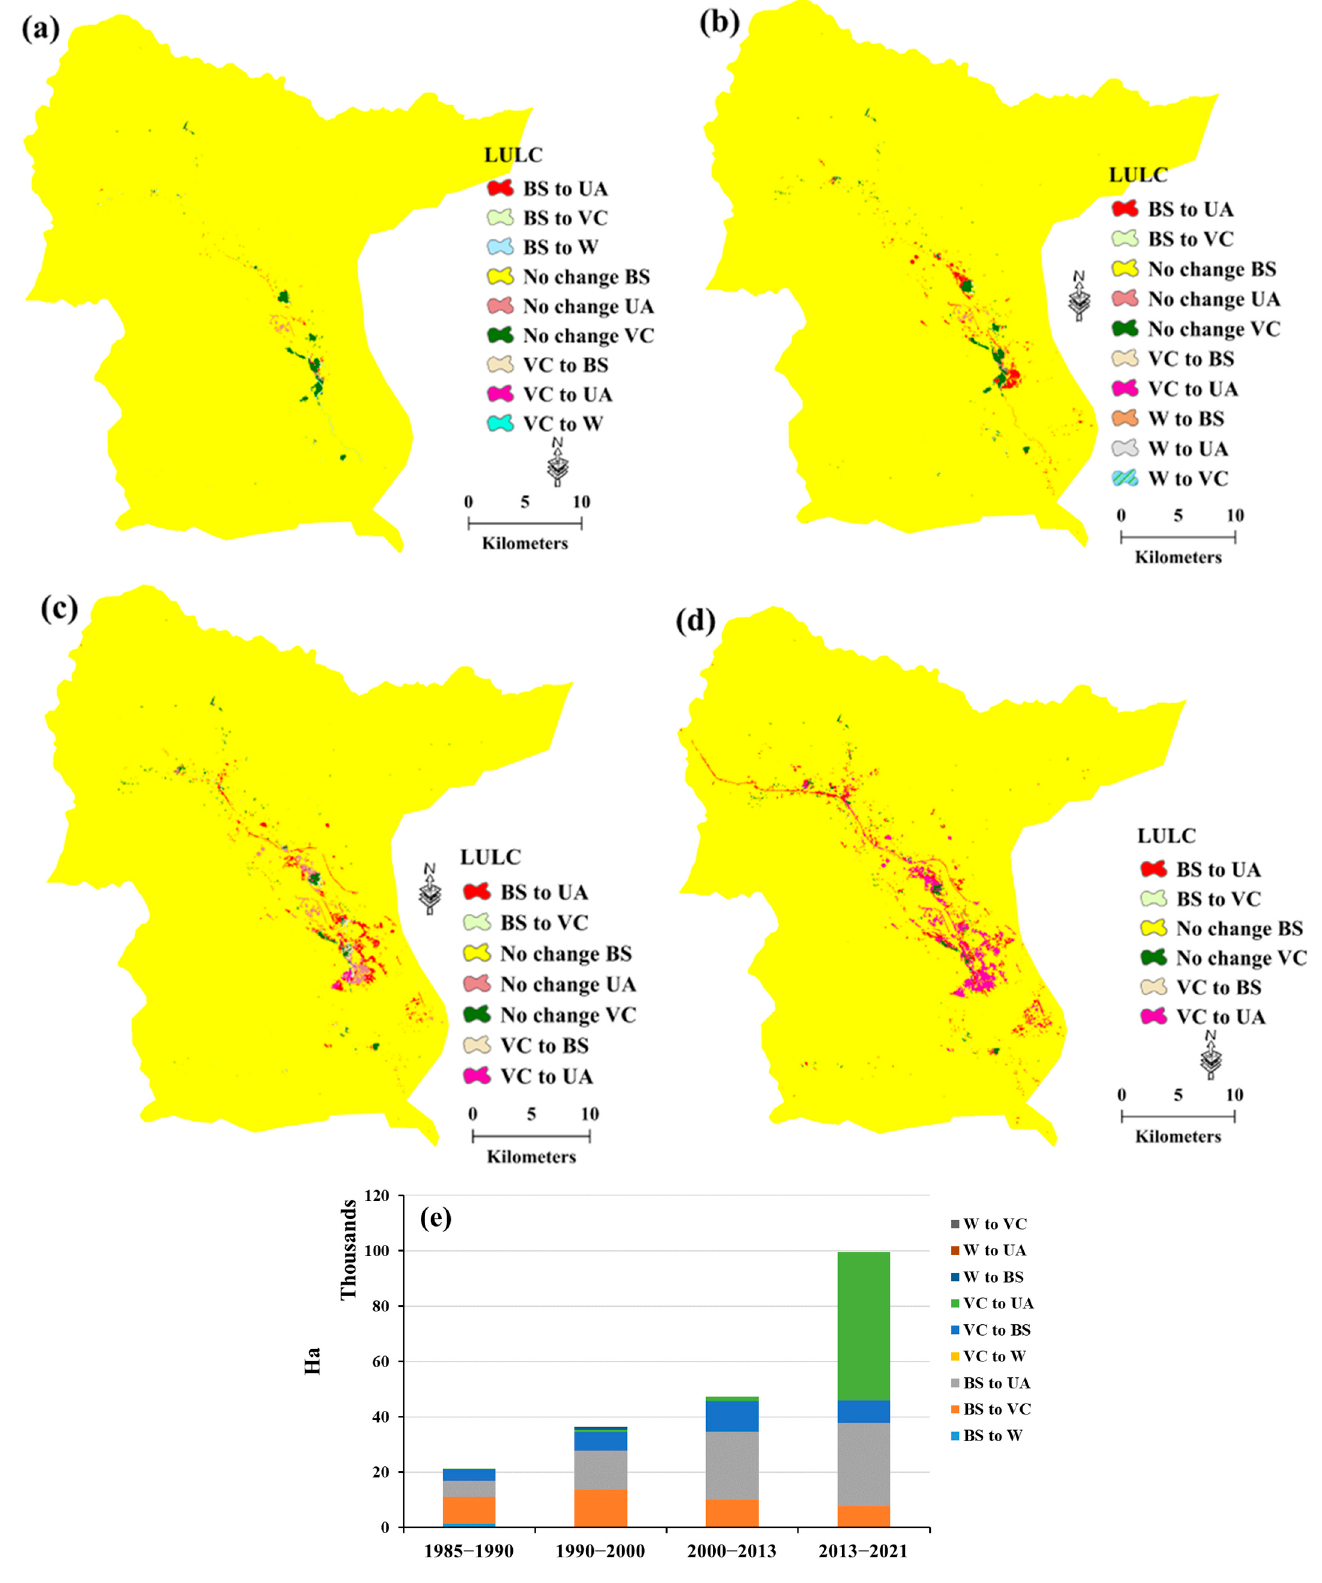
Figure 9. LULC in Ibra ( a ) 1985–1990, ( b ) 1990–2000, ( c ) 2000–2013, ( d ) 2013–2021, and ( e ) the overall LULC changes for 1985–2021 (BS = Bare Soil; VC = Vegetation Cover Soil; UA = Urban Area; W = Water).